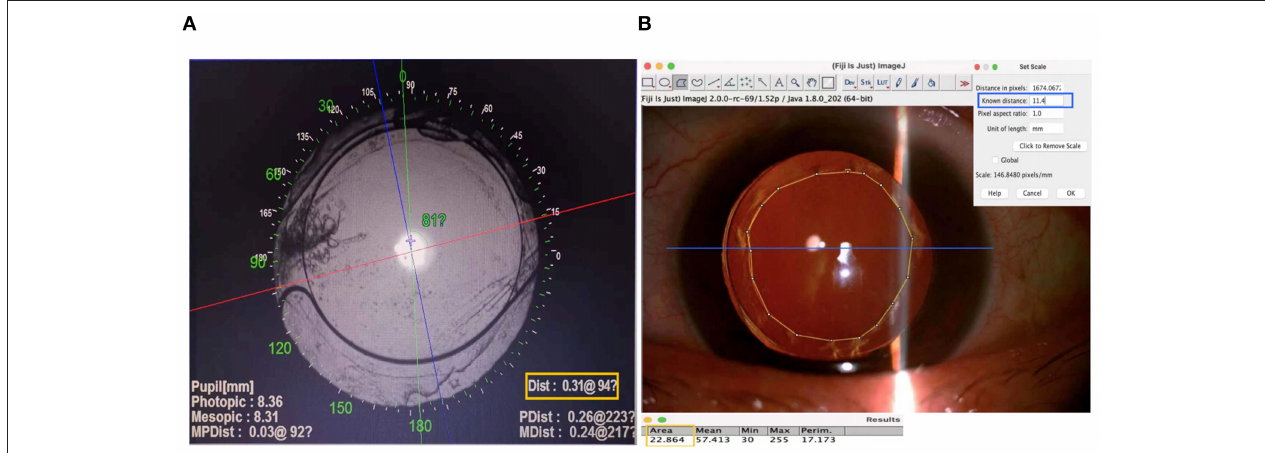
FIGURE 1 | Methods for measuring intraocular lens (IOL) decentration and anterior capsular opening area. (A) The center of the visual axis refers to the point of intersection between the red and blue lines identified by the OPD Scan III aberrometer in the retroillumination analysis mode. The center of the IOL is determined according to the exposed edge of the optical region, which is indicated by the blue cross. The value and orientation of the overall decentration are shown in the yellow box. The horizontal and vertical decentrations are then figured out. (B) A scale is first set according to the corneal diameter of each patient. The blue line in the figure refers to the corneal diameter, and its known distance is entered into the corresponding input box, as shown in the blue box. Then, the anterior capsular opening (ACO) region is circled manually, and its area is figured out as results directly by Image J, as shown in the yellow box.